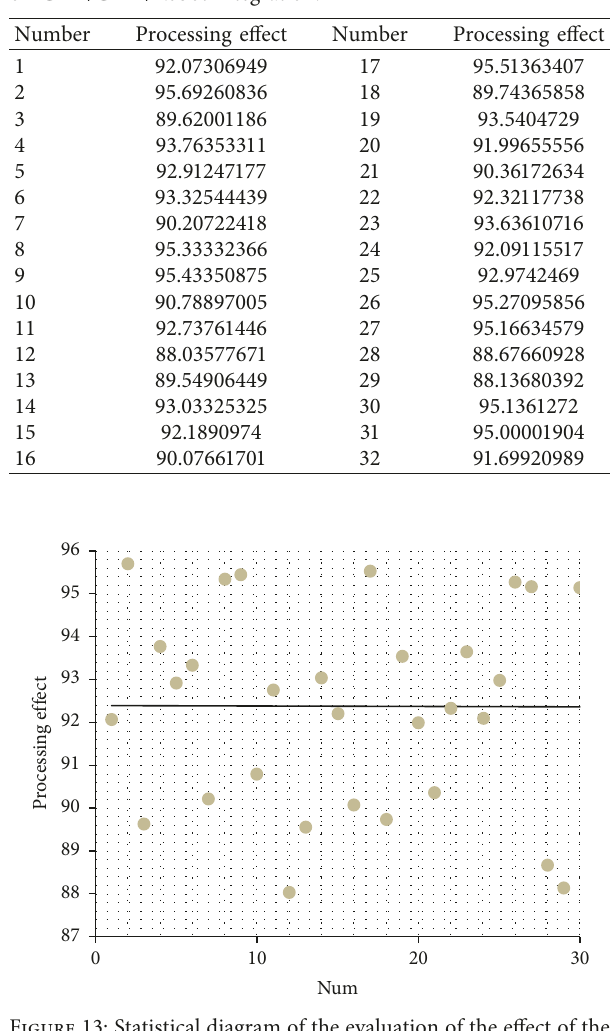
Table 1: Evaluation of the effect of CNC machining method based on CAD/CAM/Robot integration.